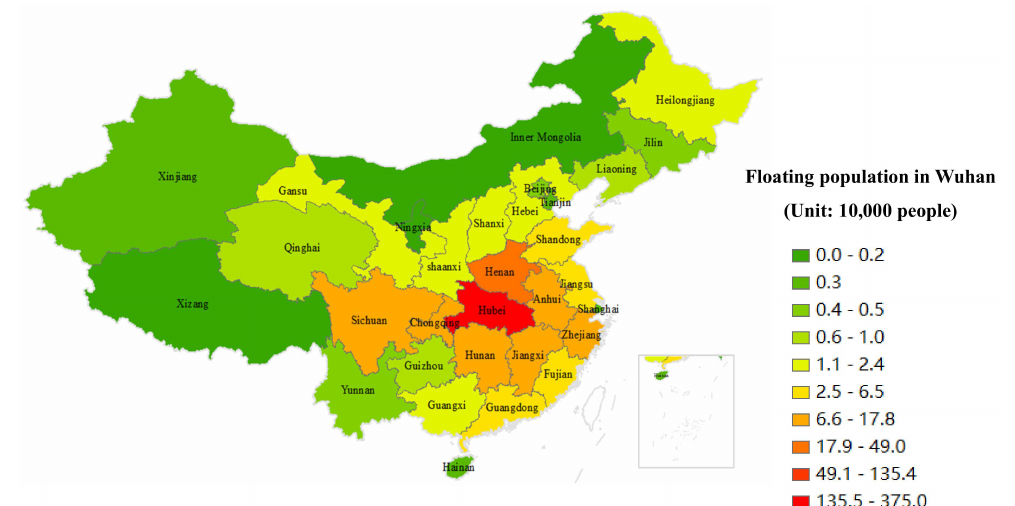
Figure 1. The national distribution of floating population in